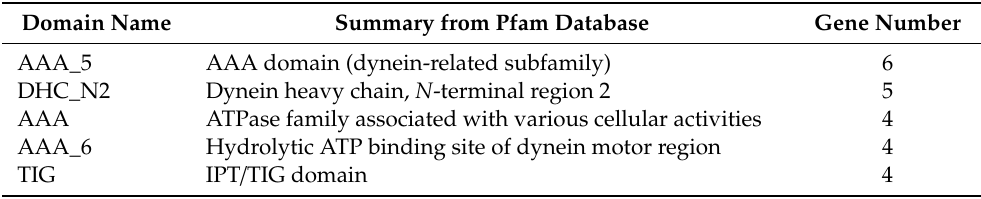
Figure 4. Heatmap and clustering of di ff erentially expressed genes (2-fold changes, p < 0.001) between dinoflagellates exposed to nano-plastics and controls. ( a ) DEGs in Symbiodinium tridacnidorum . ( b ) DEGs in Cladocopium sp. Values indicate the relative gene expression level with purple and yellow showing downregulation and upregulation, respectively. The yellow bar shows a cluster of upregulated genes. Annotations by Blast2GO show the presence of microtubule-related or photosynthesis-related genes among DEGs. Table 1. Domains encoded by more than three up-regulated genes in Cladocopium